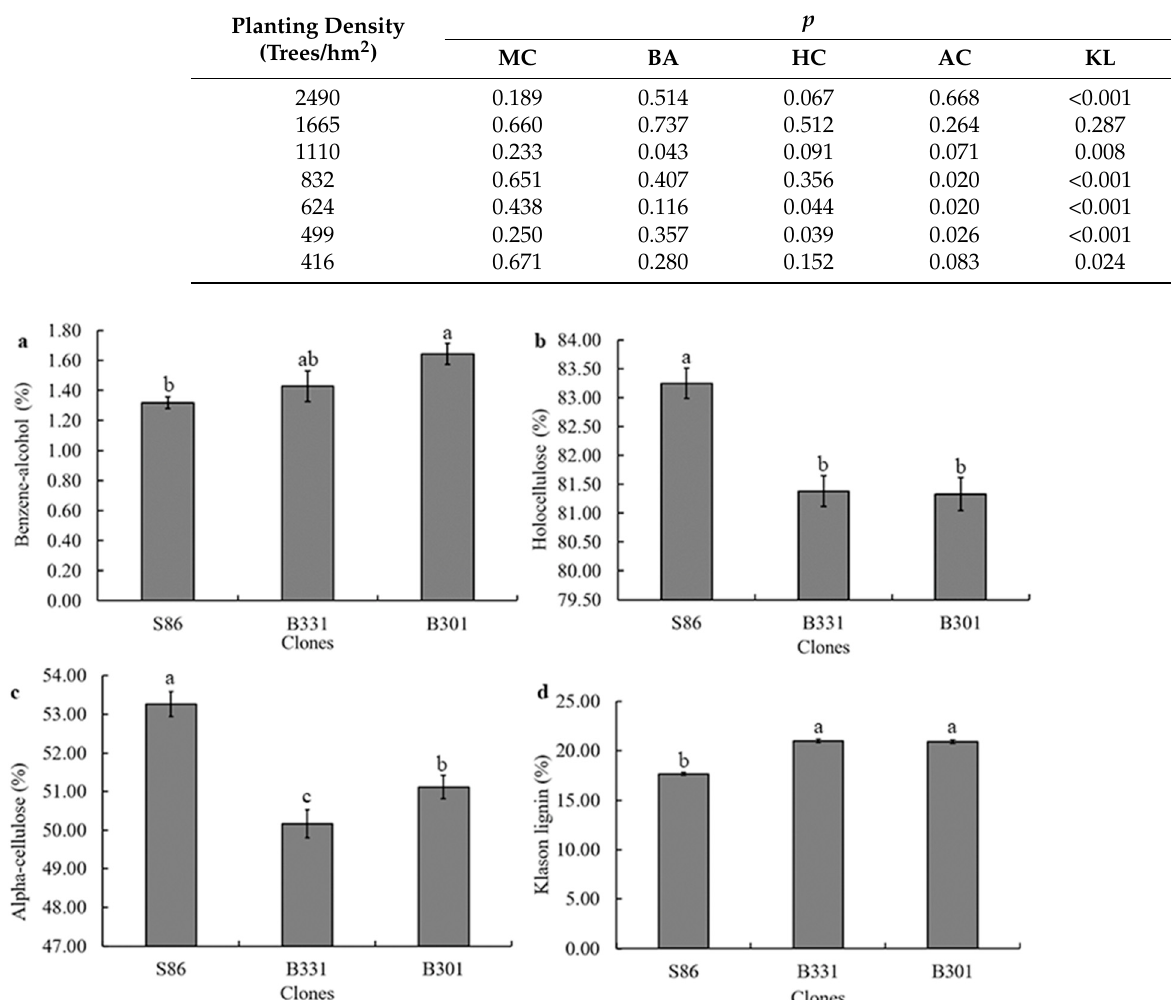
Figure 2. Effects of the clones on the content of four chemical components of the triploid Chinese white poplar: ( a ) clonal effects on the BA content of the triploid Chinese white poplar; ( b ) clonal effects on the HC content of the triploid Chinese white poplar; ( c ) clonal effects on the AC content of the triploid Chinese white poplar; ( d ) clonal effects on the KL content of the triploid Chinese white poplar. Different letters indicate significant differences ( p < 0.05). Table 4. Analysis of variance results for the moisture content and four chemical components of the 11-year-old triploid Chinese white poplar plantation within each initial planting density group.